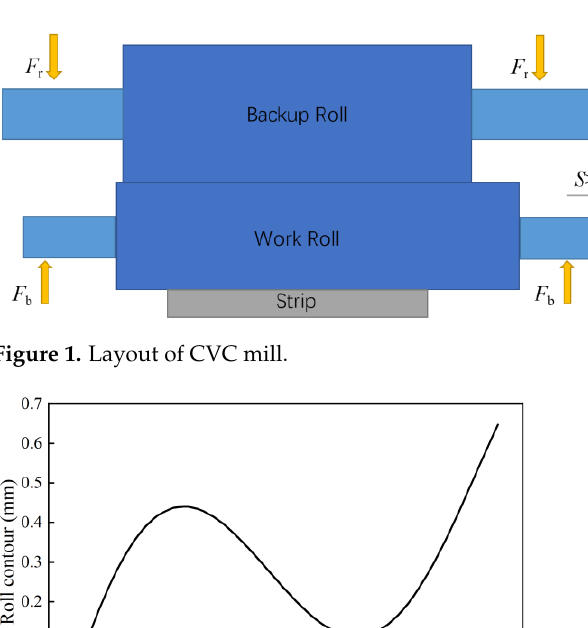
Figure 1. Layout of CVC mill.